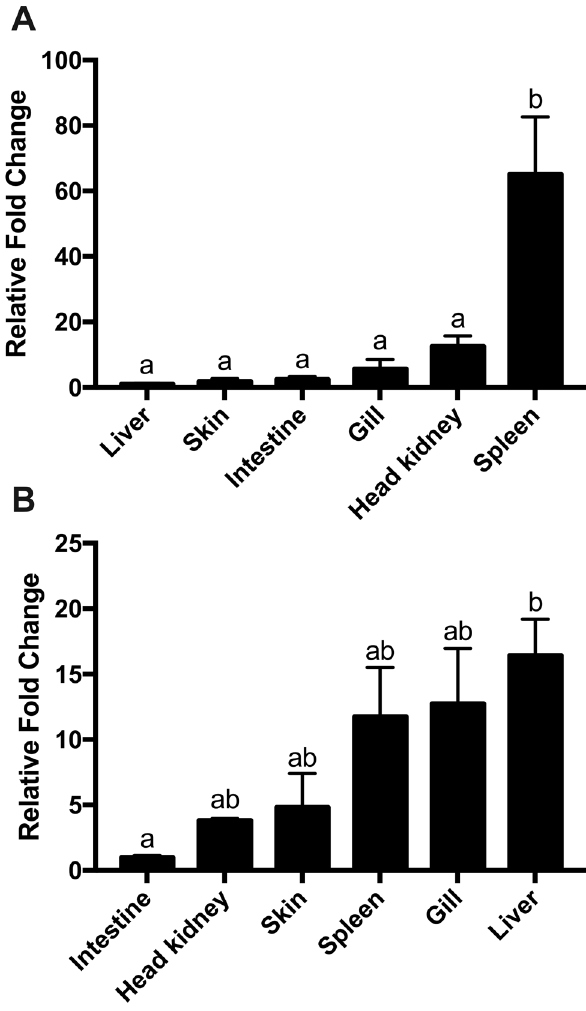
Figure 6 - Tissue distribution of mRNA expression of pmIL-1 (cid:2) (A) and pmIL-8 (B) in the liver, spleen, head kidney, gill, intestine and skin of healthy uninfected pacus. Relative mRNA expression is expressed as fold change relative to liver for IL-1 (cid:2) and to intestine for IL-8 calculated using (cid:2) -actin as endogenous reference. Data are presented as mean (cid:8) SEM (n = 5). Levels not connected by same latter are significantly different in Tukey’s test ( p (cid:7)